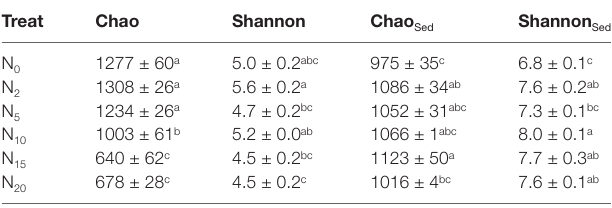
TABLE 2 | Mean (± standard error) measures for microbial richness (Chao) and diversity (Shannon) in water and sediment across the nitrogen gradient. . Treat Chao Shannon Chao